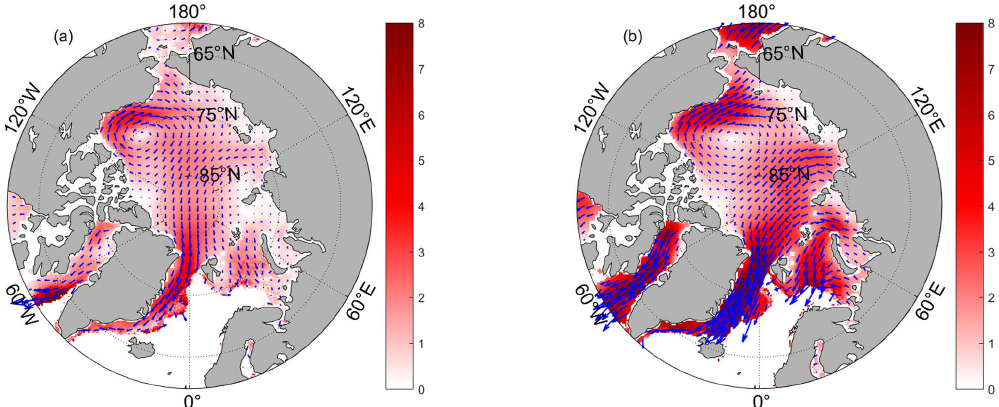
Figure 3. Climatological distribution of the sea ice drift speed field in summer (a) and winter (b) from 1979 to 2018 (the different shading represents the velocity, and the arrows represent the direction and magnitude of ice